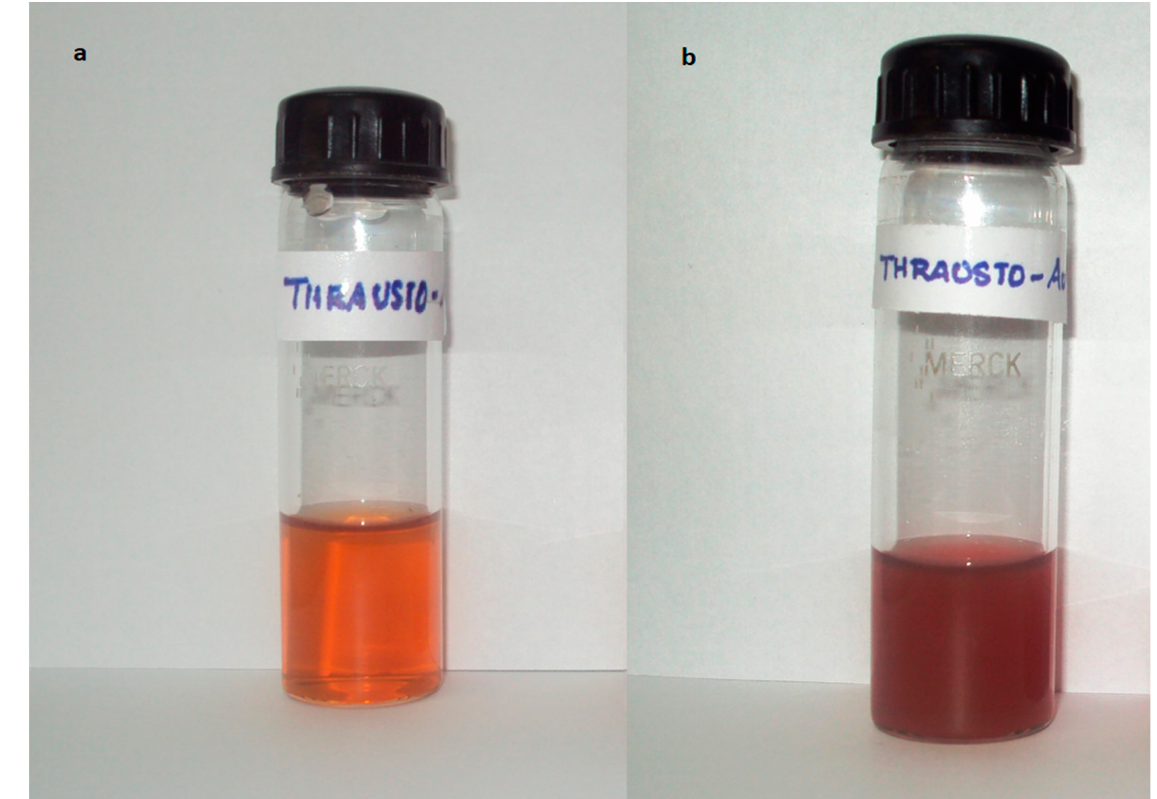
Figure 5. Nanoparticles synthesized by Thraustochytrium kinnei: ( a ) silver nanoparticles; ( b ) gold nanoparticles.